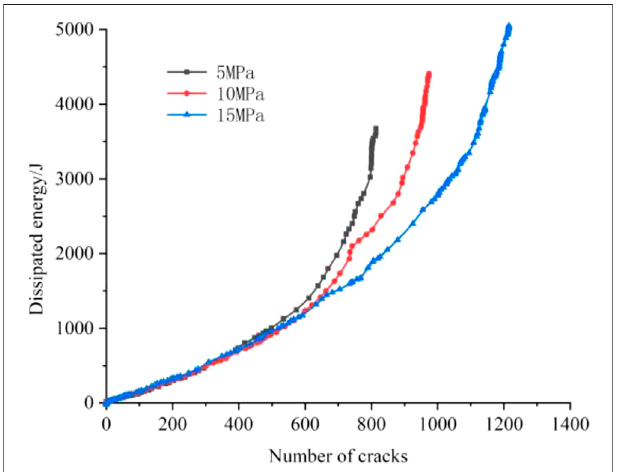
FIGURE 8 | Relationship between dissipation energy and cracks under different con fi ning